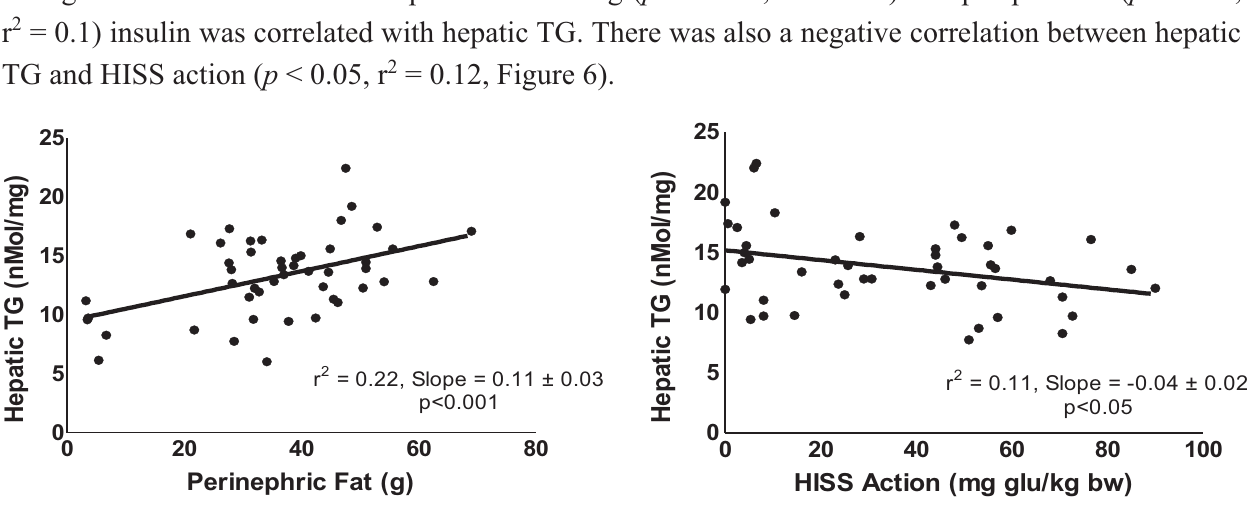
Figure 6. Correlation of hepatic triglycerides with fat pad mass and HISS action. Although total body and regional fat pad masses increase early in AMIS syndrome, hepatic TG elevations become significant only in the aged ± sucrose groups. Also, a significant correlation (r 2 = 0.22; p < 0.001) between hepatic TG and perinephric fat indicates that the fatty liver is a later, but predictable, component of the AMIS syndrome. An inverse correlation (r 2 = 0.11; p < 0.05) exists between HISS action and hepatic